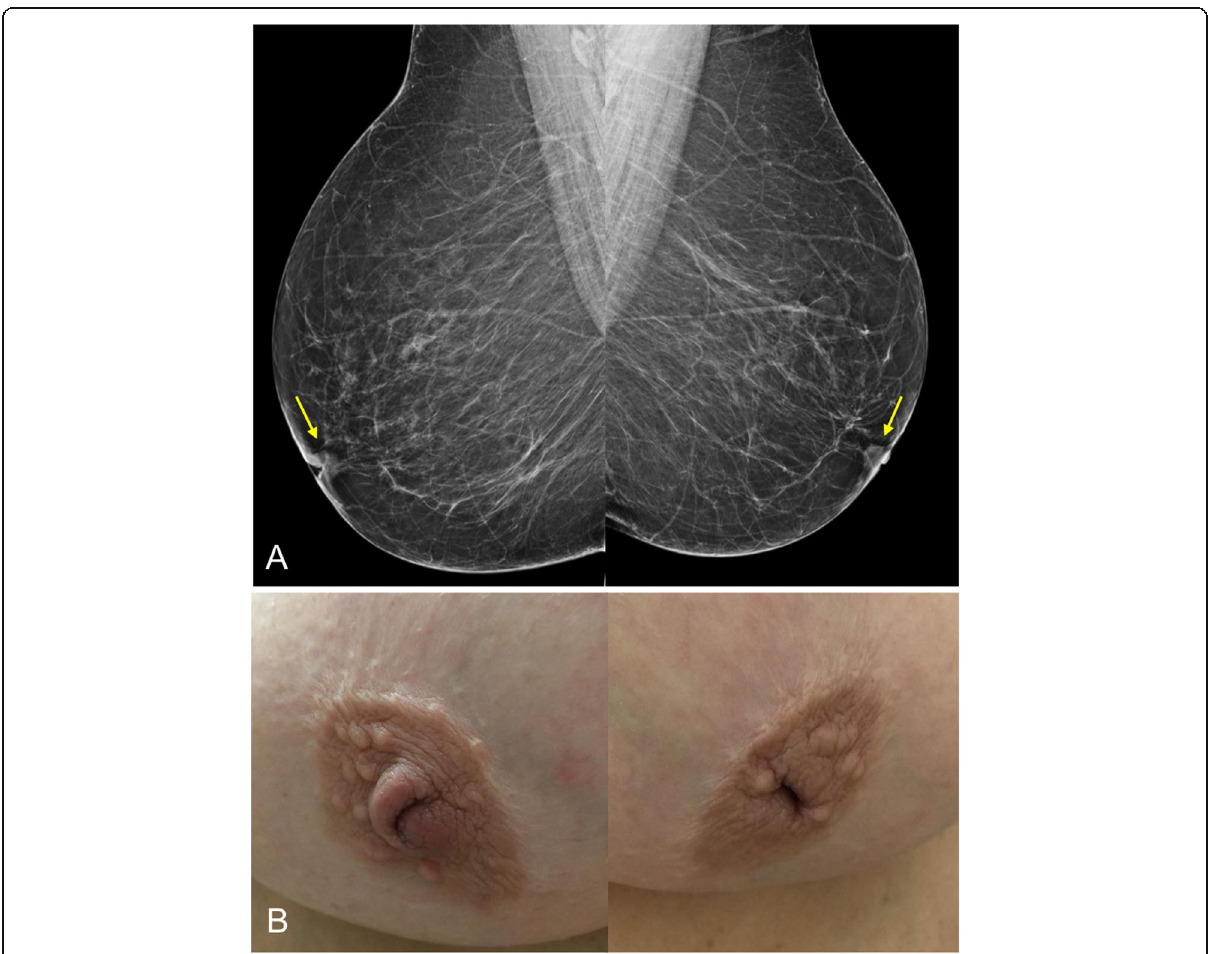
Fig. 7 Inverted nipples. A 60-year-old woman with inverted nipples. a Craniocaudal 2D mammograms show bilateral inverted nipples that are perfectly tangential and symmetrical. b Photograph of the same